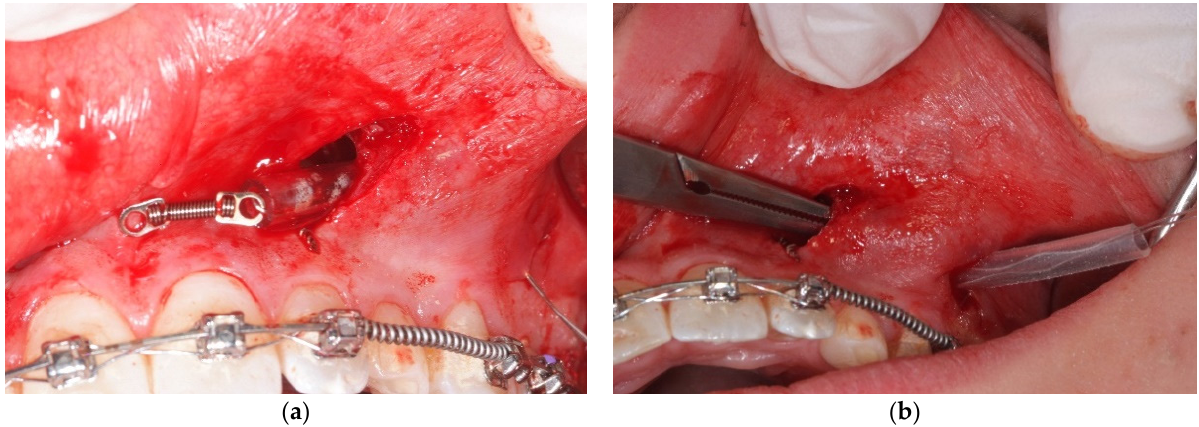
Figure 1. NiTi coil spring 100 gr ( a ) covered with a soft sleeve ( b ) to avoid the insertion of soft tissue in the coils’ loops.